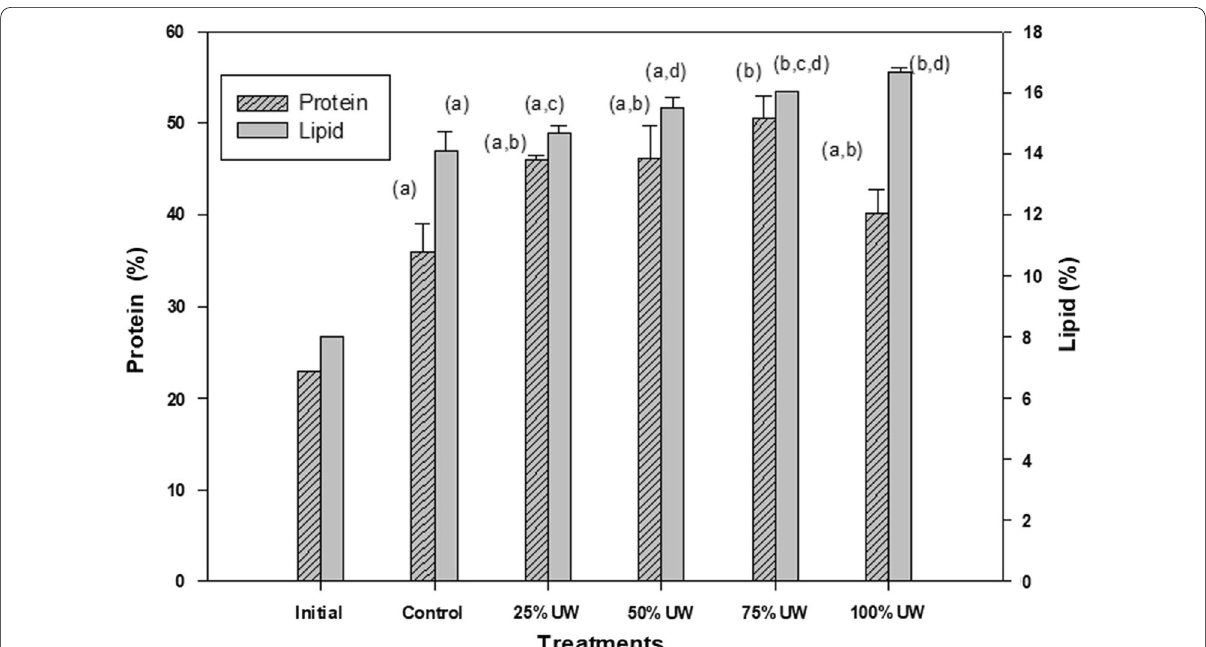
Fig. 3 Protein (grated bars) and lipid (solid bars) percentage contained in C. fusca in the different treatments (control, 25% UW, 50% UW, 75% UW, and 100% UW) at the end of the incubation period (14 days). The same letters indicate no significant differences between the groups ( p > 0.05). Data are expressed as mean standard deviation (n 3) ± =